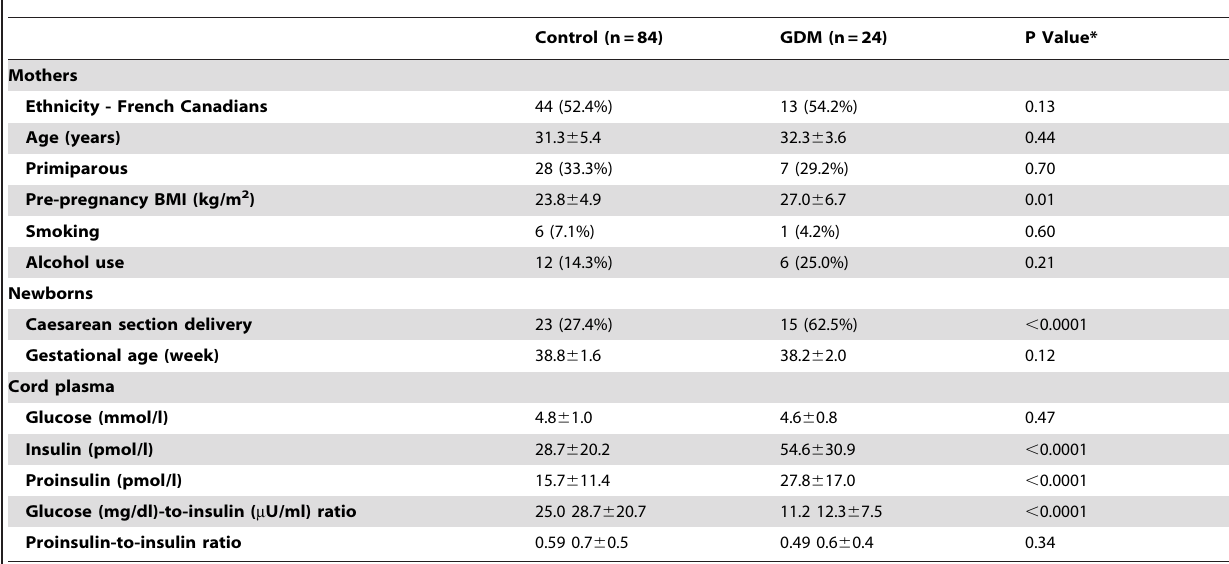
Table 1. Maternal and neonatal characteristics of study